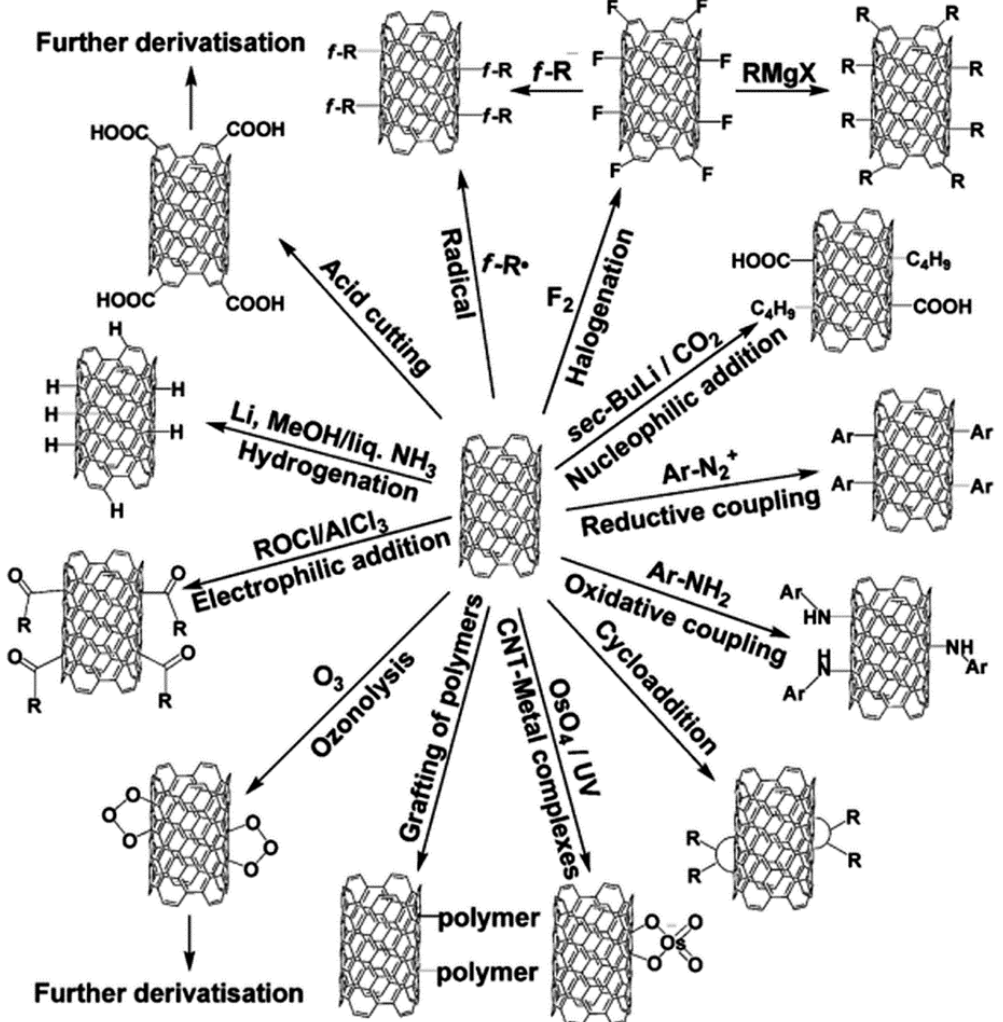
Figure 4. Examples of surface modifications on carbon nanotubes (CNTs) [163].